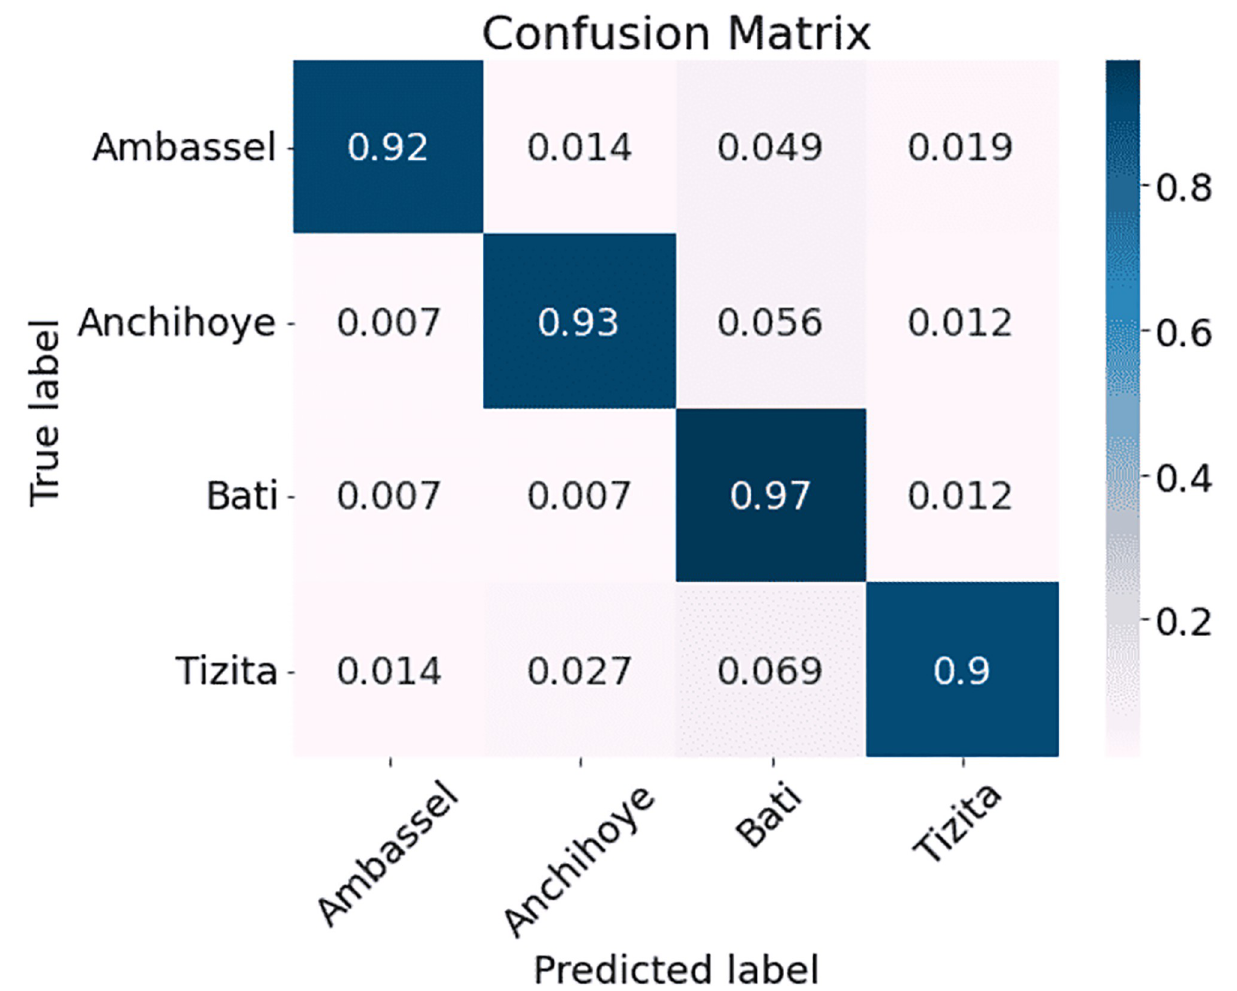
Fig 3. Experiment 1: EKM confusion matrices using MelSpec on